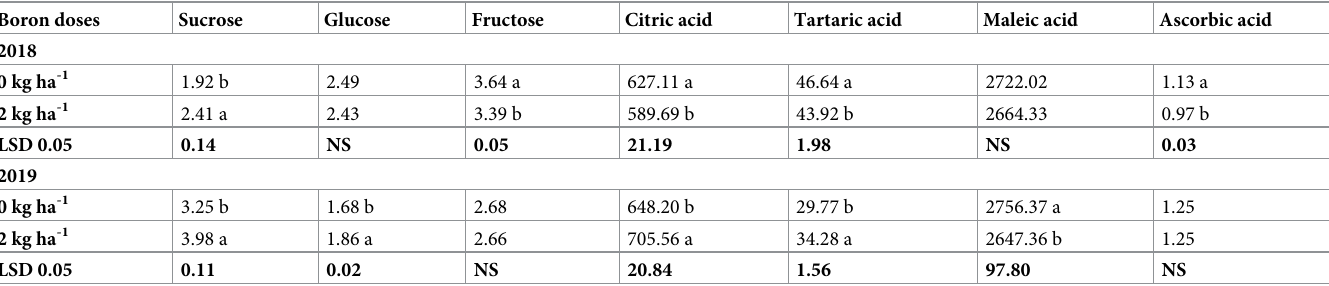
Means followed by similar letters within a column are statistically non-significant (p > 0.05).